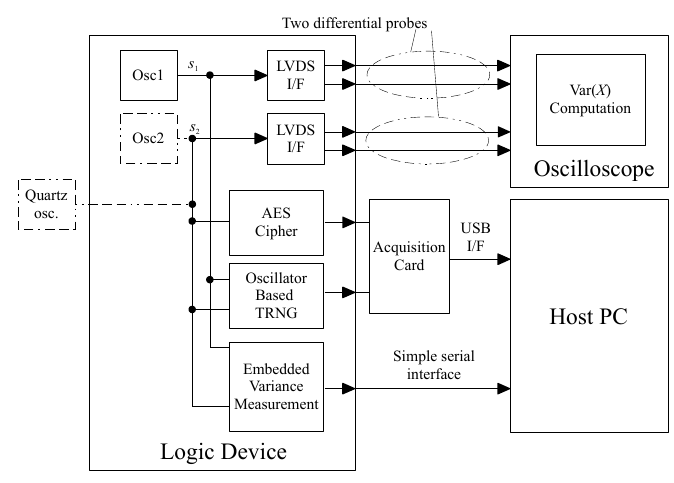
Figure 13: External jitter measurement method using an oscilloscope and differential probes combined with an internal jitter measurement method while the TRNG and the AES cipher are running (only one generator of signal s 2 is present in each of the two projects: Quartz oscillator in Project 2 and Osc 2 in Project 3) To ensure the measurement results are consistent, it is important to guarantee the same placement and routing of Osc1 and Osc2 in all projects. We generated the Exported Partition file (.qxp), which is the Quartus II software option used to export post-fitting netlists. The exported netlist was then used in all the